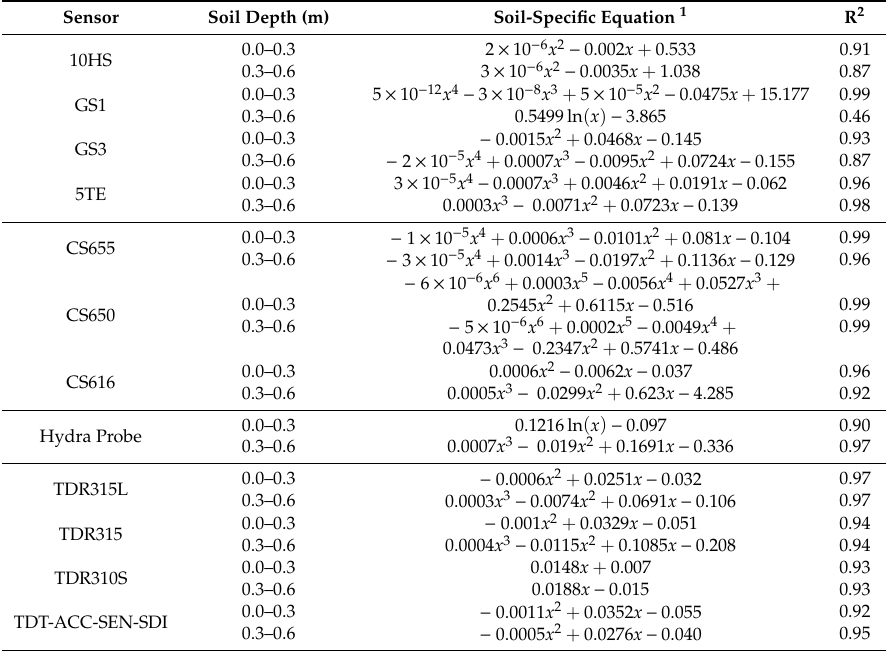
1 Variable corresponds to the response value of the sensor (voltage, period, or dielectric constant). The obtained result from each equation is the soil volumetric water content ( θ v ). Measuring technique: Frequency Domain Reflectometry—FDR (10HS, GS1, GS3, and 5TE); Transmission Line Oscillation—TLO (CS655, CS650, and CS616); Time Domain Reflectometry—TDR (Hydra Probe, TDR − 315L, TDR − 315, and TDR − 310S); and Time Domain Transmissometry—TDT